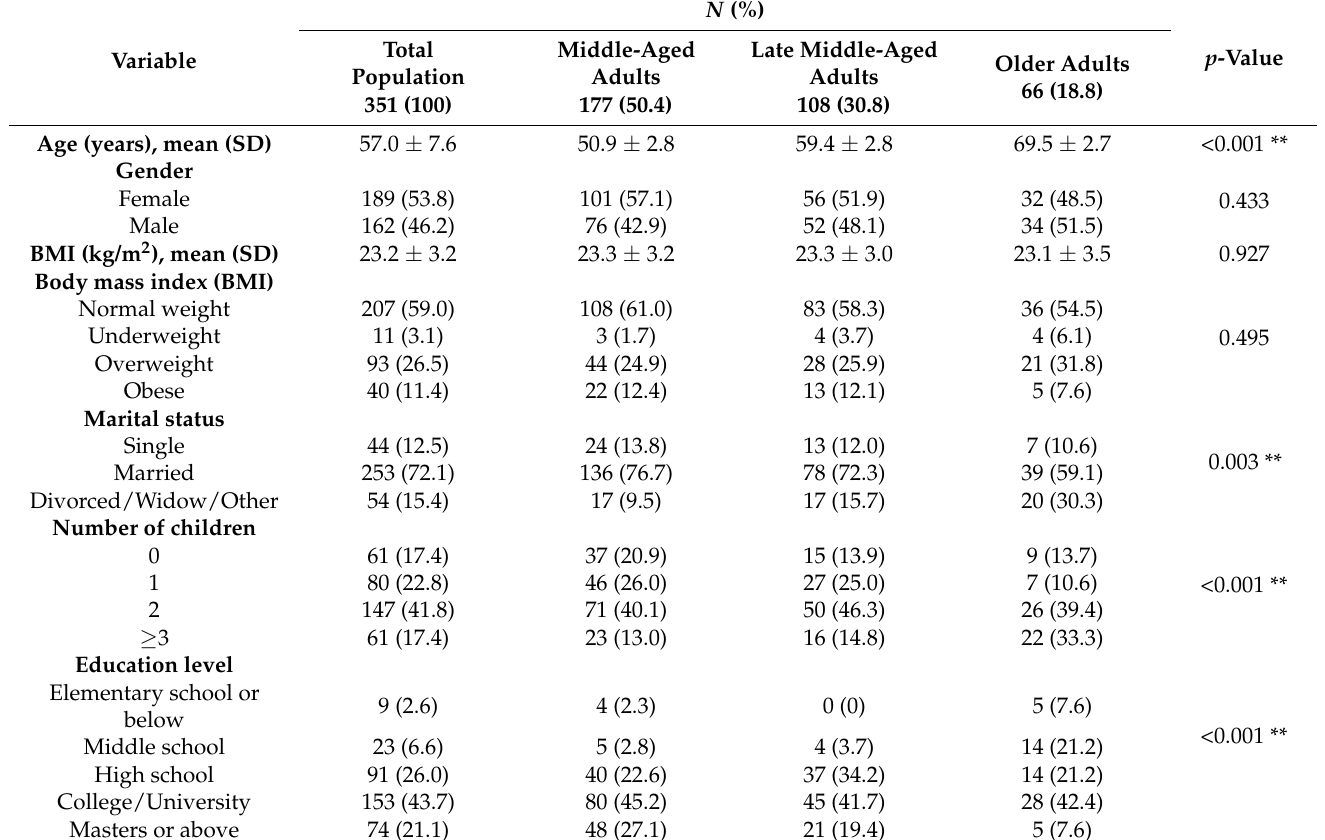
Table 1. Basic demographic statistics of the study participants ( N =